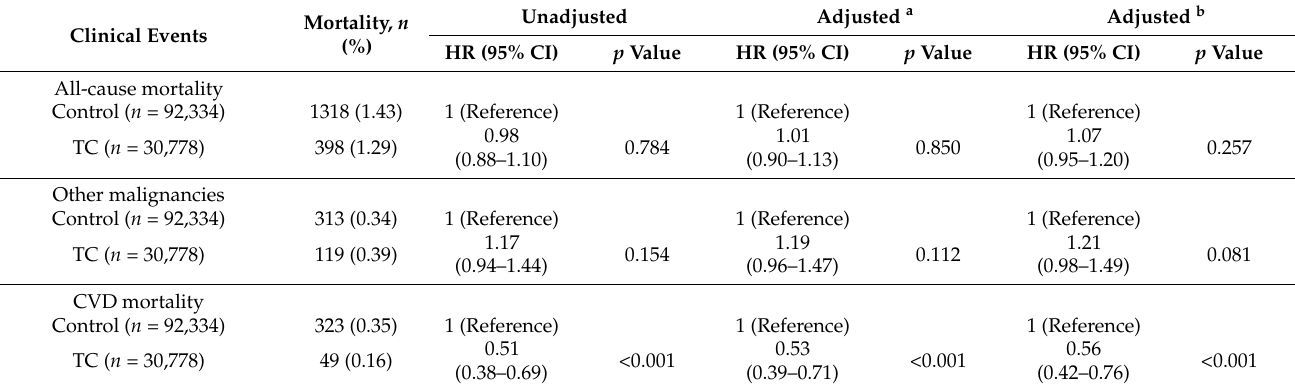
Table 3. Comparison of all-cause, other malignancies, and cardiovascular disease mortality between the thyroid cancer group and the